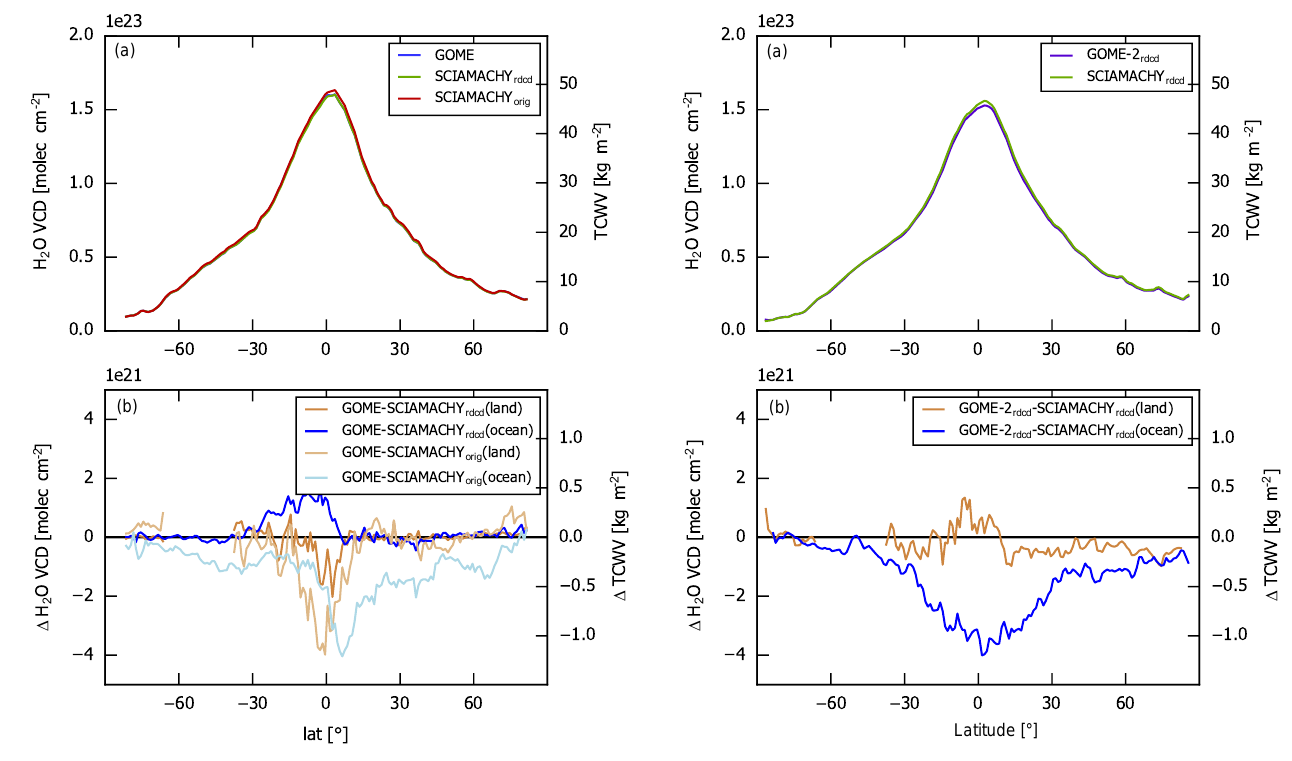
Figure 4. (a) Zonal mean TCWV for GOME and SCIAMACHY (at original as well as reduced resolution) as a function of lati- tude. (b) Differences of zonal mean TCWV between GOME and SCIAMACHY at original (light) and reduced (dark) resolution, sep- arately for land (orange) and ocean (blue).